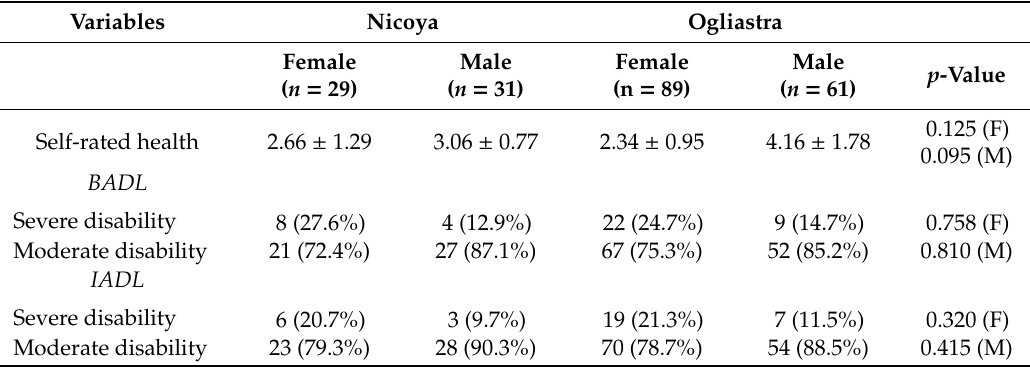
Table 3. Basic activities of daily living and instrumental activities of daily living recorded among 210 Nicoyan and Sardinian